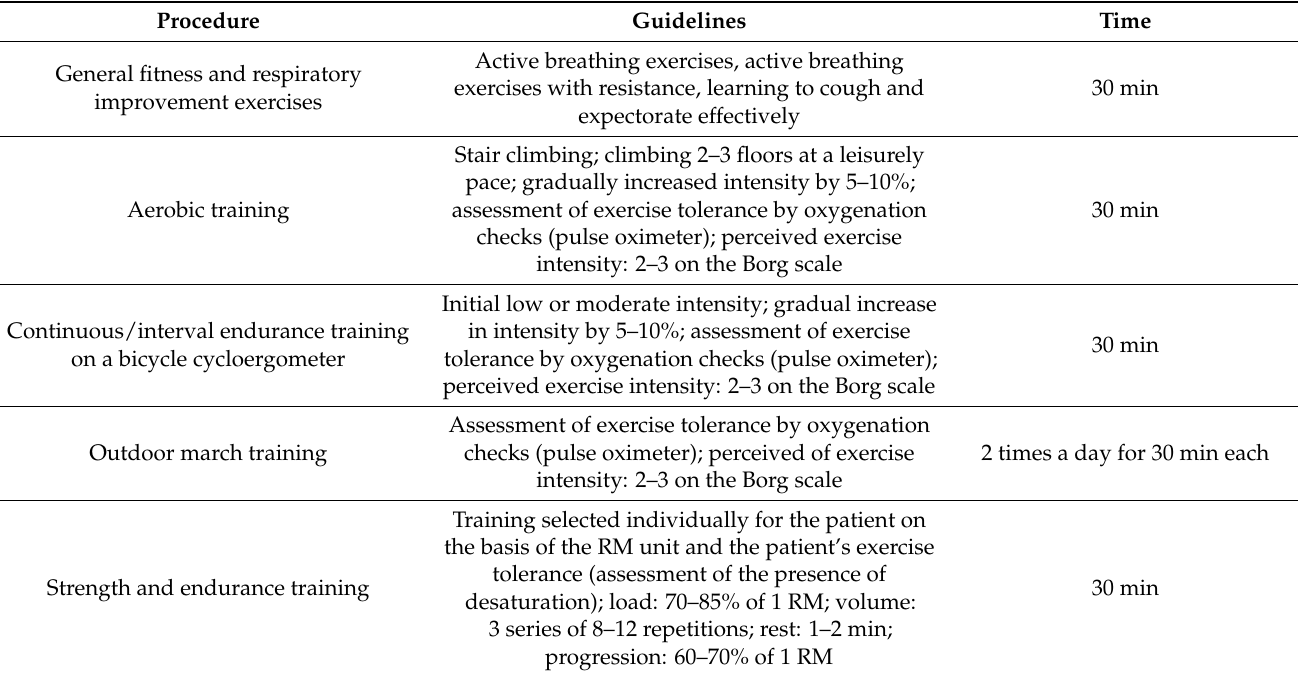
Table 1. Rehabilitation program.